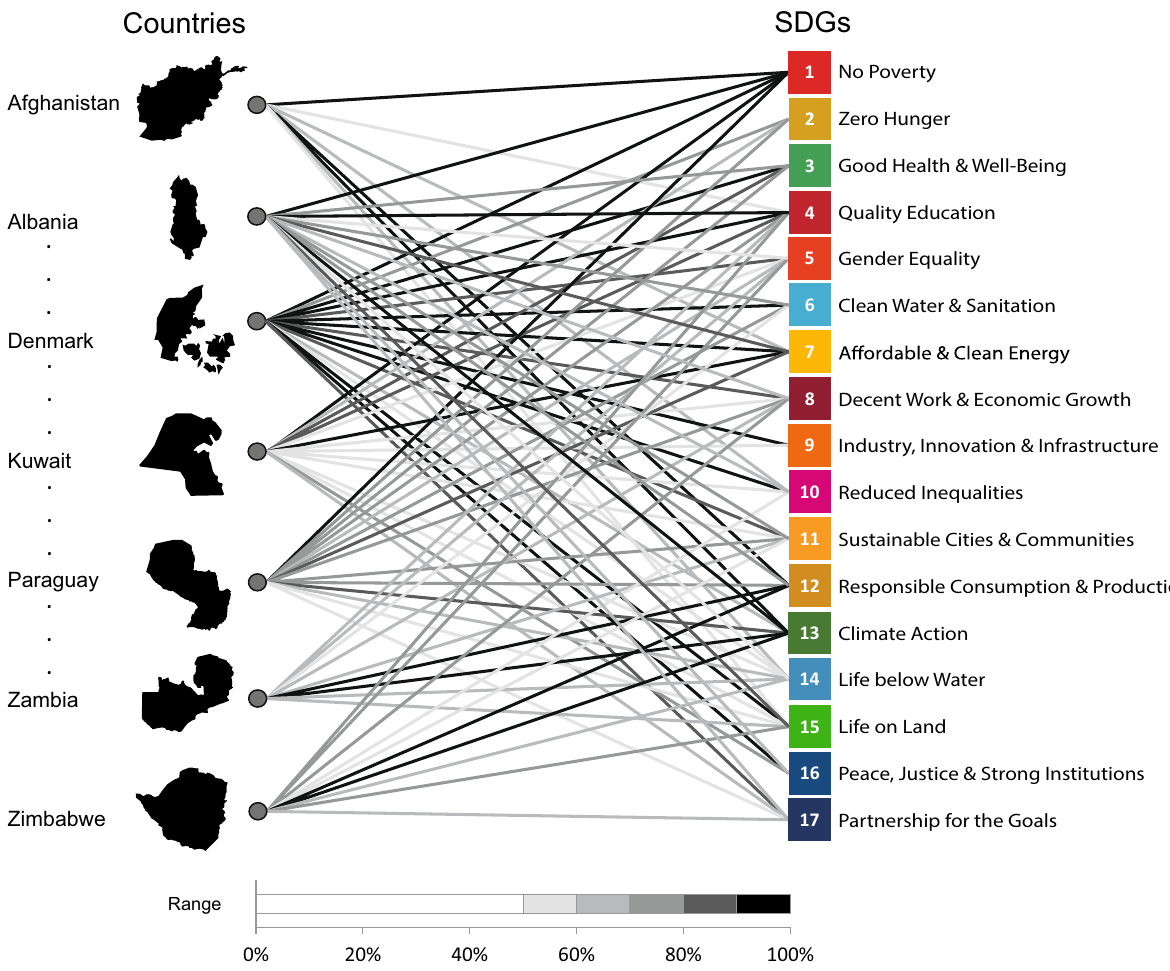
Figure 1. The bipartite network of countries and Goals. Qualitative representation of the bipartite network constituted by countries and Goals. On the left, we list seven of the countries that can be found by browsing the 2020 Dashboard, sorted in alphabetical order 26 (the first and last two countries and the ones found at first, second and third quarter of the list). On the right, the 17 SDGs are reported. For each country, we connect the SDGs via the performance values P cg in each Goal, according to the 2020 Dashboard data 26 . The values P cg are intended to be readable as a percentage of achievement of the Goals. We have classed these values in ranges of 10% of performances and colour-coded, in greyscale, accordingly: the darker the links, the better the performances of the country within the Goals. Countries’ performances smaller than 50% have been left blank. The figure has been generated using Matlab R2019b, [https:// www. mathw orks. com/ produ cts/ matlab. html], and PowerPoint